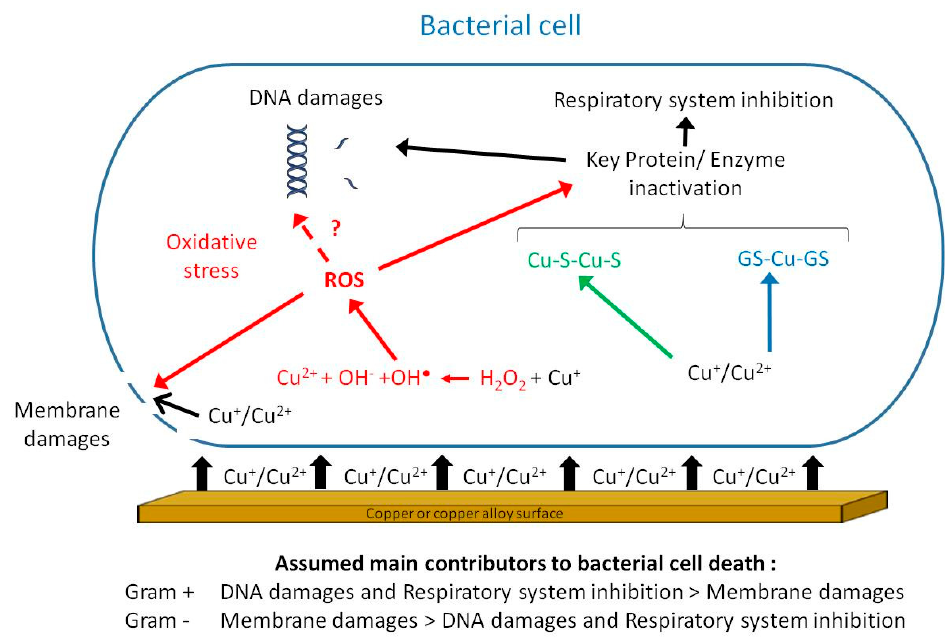
Figure 1. Putative mechanisms involved in contact killing: direct destruction of the membrane by cupric and cuprous ions (black pathway); hydrogen peroxide-dependent oxidation of Cu + in the cell under aerobic conditions generating reactive oxygen species (ROS) (red pathway); interactions between copper ions and glutathione under anaerobic conditions (blue pathway) and displacement of iron from iron-sulfur clusters (green pathway). The final steps leading to bacterial cell death include inactivation of key proteins/enzymes, among which are those involved in the respiratory system as well as membrane and DNA damages.